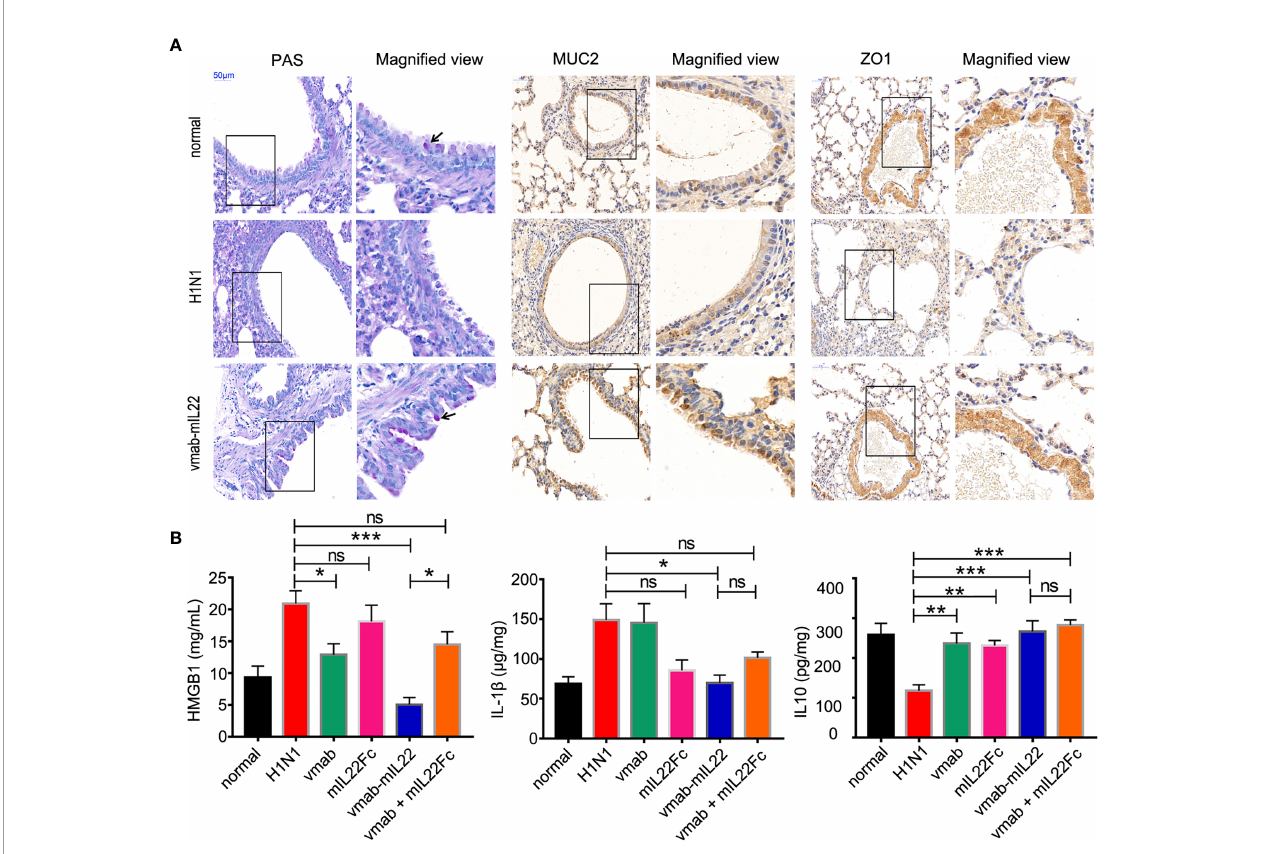
FIGURE 5 | Vmab-mIL22 treatment increased epithelial repair and modulated in fl ammatory cytokine levels. (A) Recovery of pulmonary goblet cells and the mucus layer in the vmab-mIL22 treatment group. Pulmonary goblet cells are visualized by PAS staining. Black arrows indicate the goblet cells. MUC2 and ZO1 protein expression was assayed via immunohistochemistry. (B) Cytokines in the serum or lung homogenate were assayed using ELISA.There are seven mice in each group (n = 7). Values were expressed as mean ± SEM. Multiple group comparisons were performed using one-way analysis of variance (ANOVA) followed by Bonferroni post hoc test using the software of SPSS. p-value of less than 0.05 was considered to be signi fi cant. *P < 0.05, **P < 0.01 or ***P < 0.001. NS, not signi fi